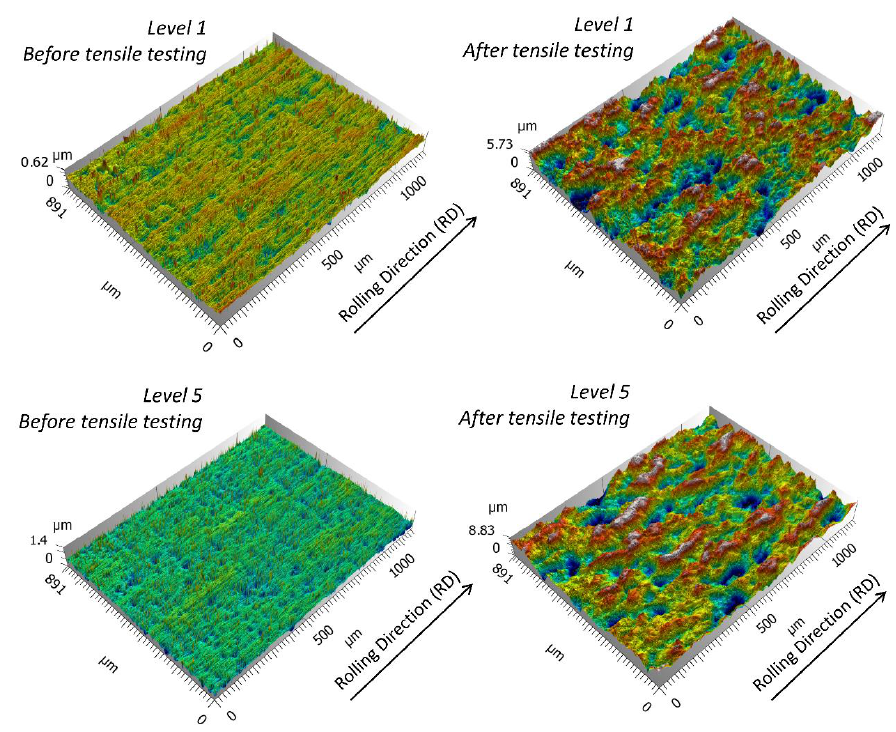
Figure 1. Examples of topography measurements of 1188 µ m × 891 µ m for roping classified as Level 1 and Level 5, before and after tensile testing.